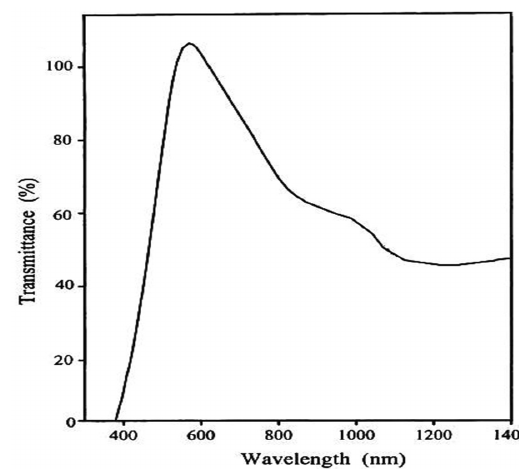
Figure 3. AFM images of CuSe thin film (a) 2 dimension (2D) and (b) 3dimension (3D). Figure 4. UV‑Vis transmission spectrum of CuSe